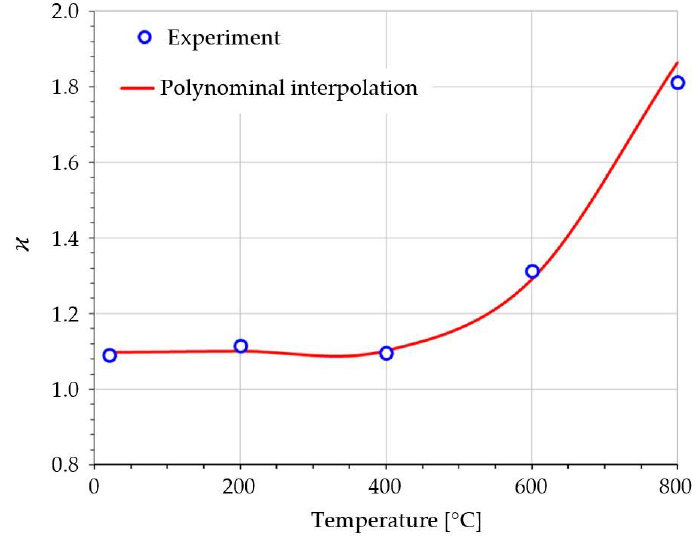
Figure 4. St12T steel elastic region asymmetry coefficient vs. temperature